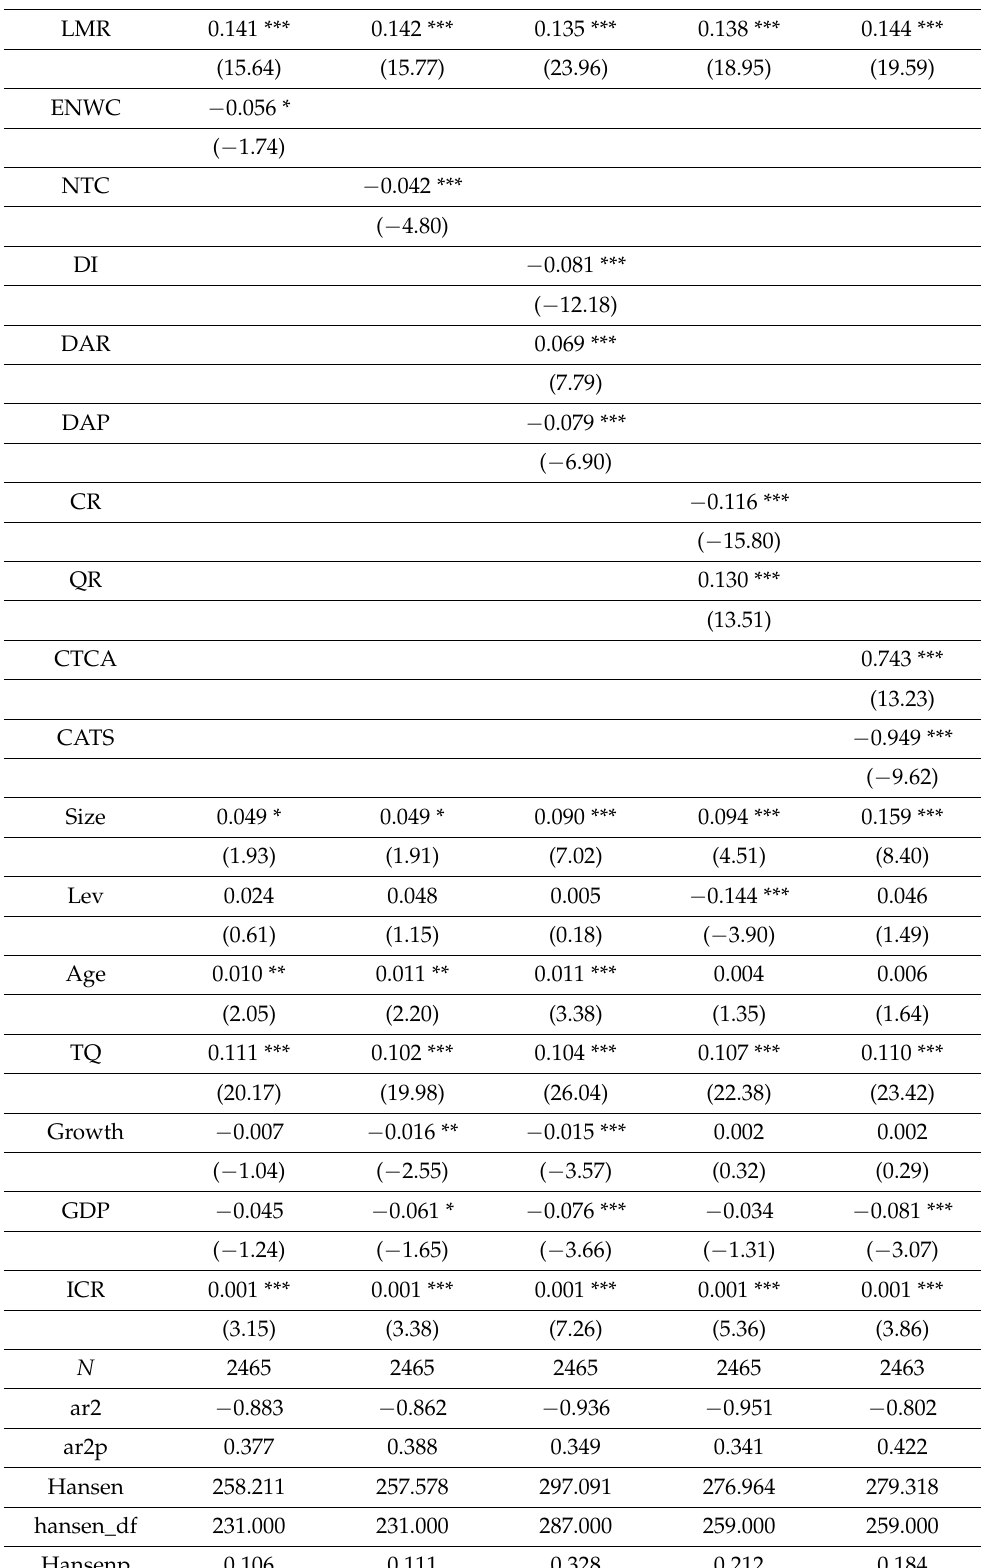
Table 4. Results of GMM regressions. Market risk is the dependent